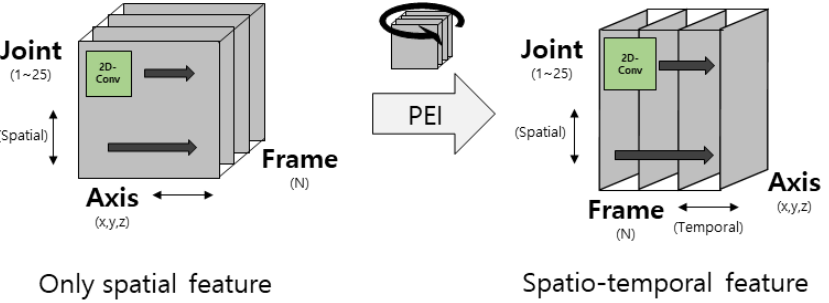
Figure 2. Comparison of feature extraction before and after pose evolution image (PEI) conversion.